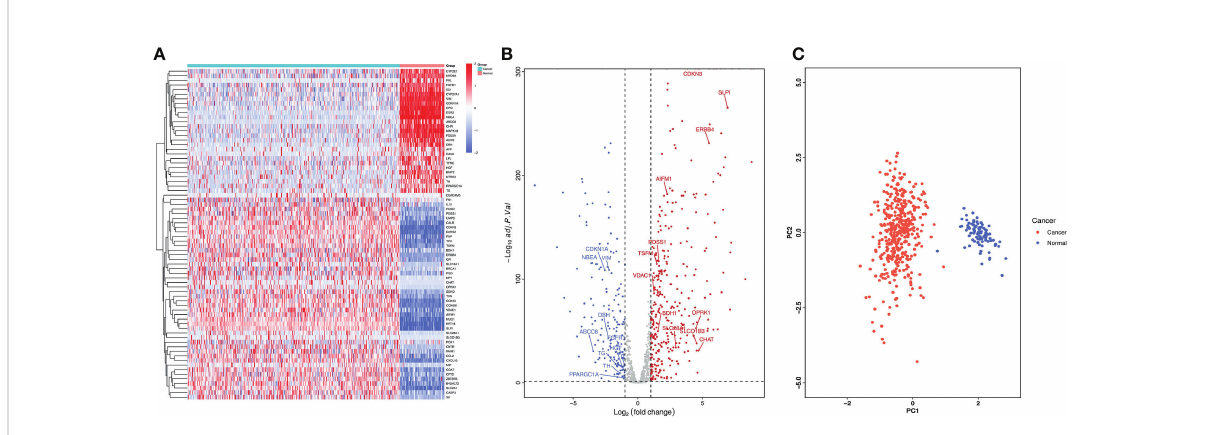
FIGURE 1 Differentially expressed LMRGs in ovarian cancer in the TCGA dataset. (A) Heatmap of LMRGs between ovarian cancer and normal ovarian tissues, the color from blue to red represents the progression from low expression to high expression. (B) Volcano plot of LMRGs, the red dots in the plot represents upregulated genes and blue dots represents downregulated genes with statistical signi fi cance. Gray dots represent no differentially expressed genes. (C) PCA map of DEGs related to lactate metabolism distinguishing ovarian cancer from normal